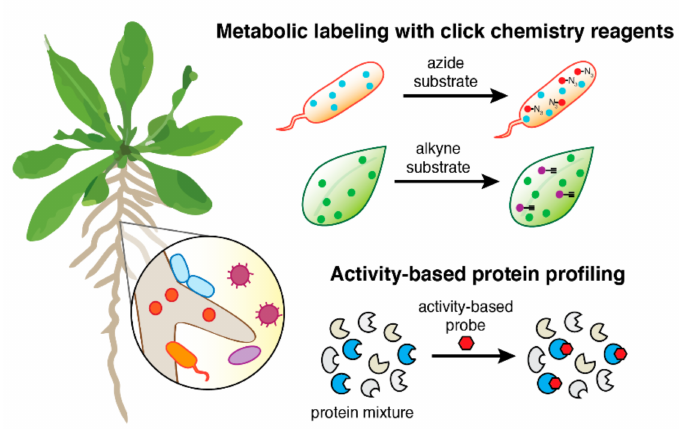
Figure 1. Click chemistry reagents and activity-based probes as chemical tools for studying plant- microbe interactions. Metabolic labeling of live microbes and plant tissues with azide- or alkyne- modified glycan, monolignol, lipid, or amino acid substrates enables click chemistry attachment of various tags for imaging or affinity enrichment. Activity-based probes label enzymes based on their specific mechanisms of action, allowing for functional characterization of proteins even in complex, poorly annotated biological